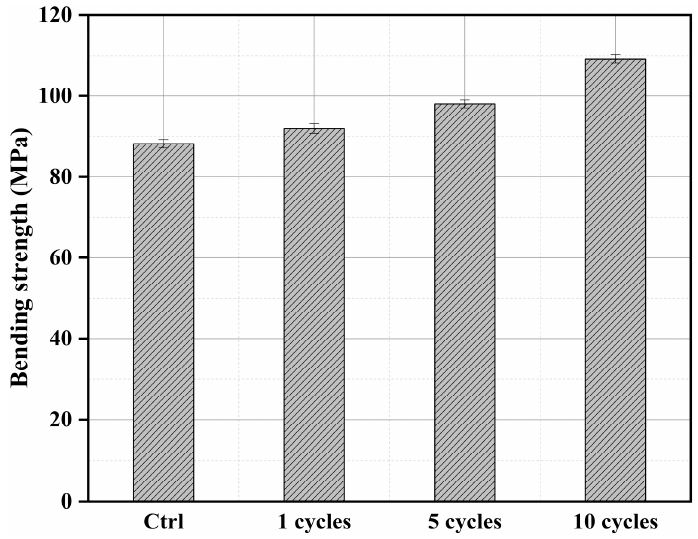
Figure 7. Bending strengths of the Mongolian Scots pine at di ff erent cycles treated.